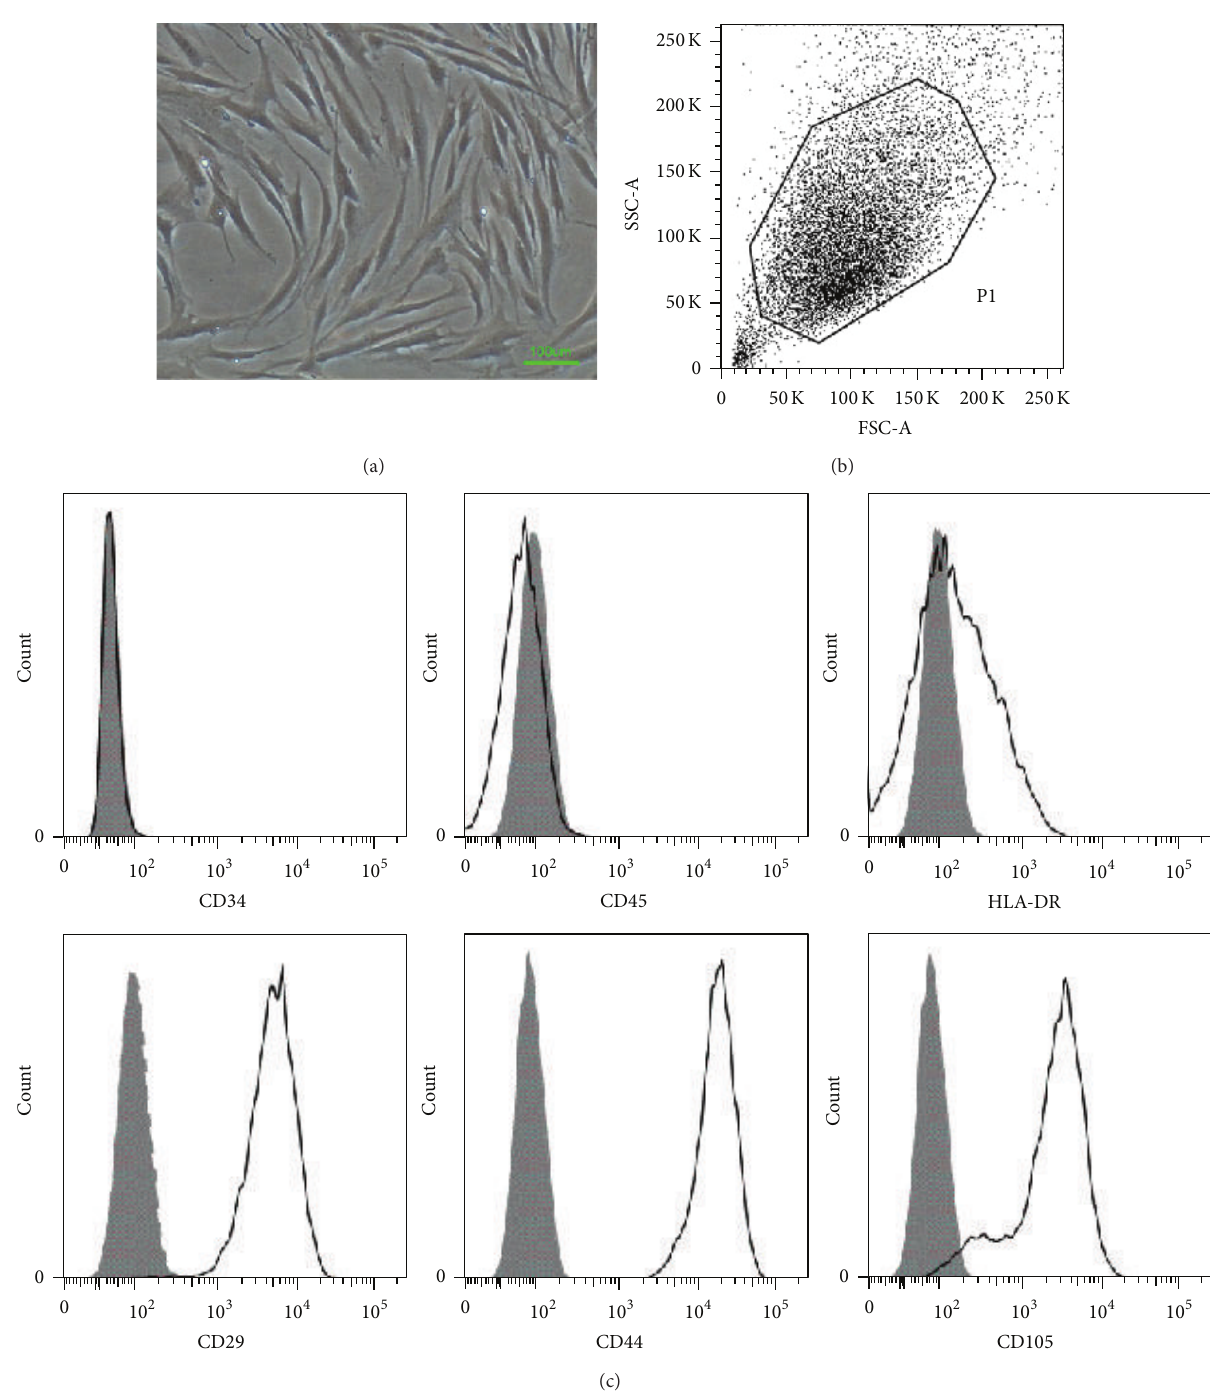
Figure 1: Immunophenotype and differentiation of MSCs. (a) Under the 40x microscope, spindle-shaped MSCs grow like intersecting bundles. (b) Dot plot data showing all (nongated) cells as well as gated hMSC (P1). (c) MSCs were harvested, labeled with antibodies against immunophenotype, and analyzed by flow cytometry. MSCs expressed CD29, CD44, and CD105 but not CD34, CD45, and HLA-DR.